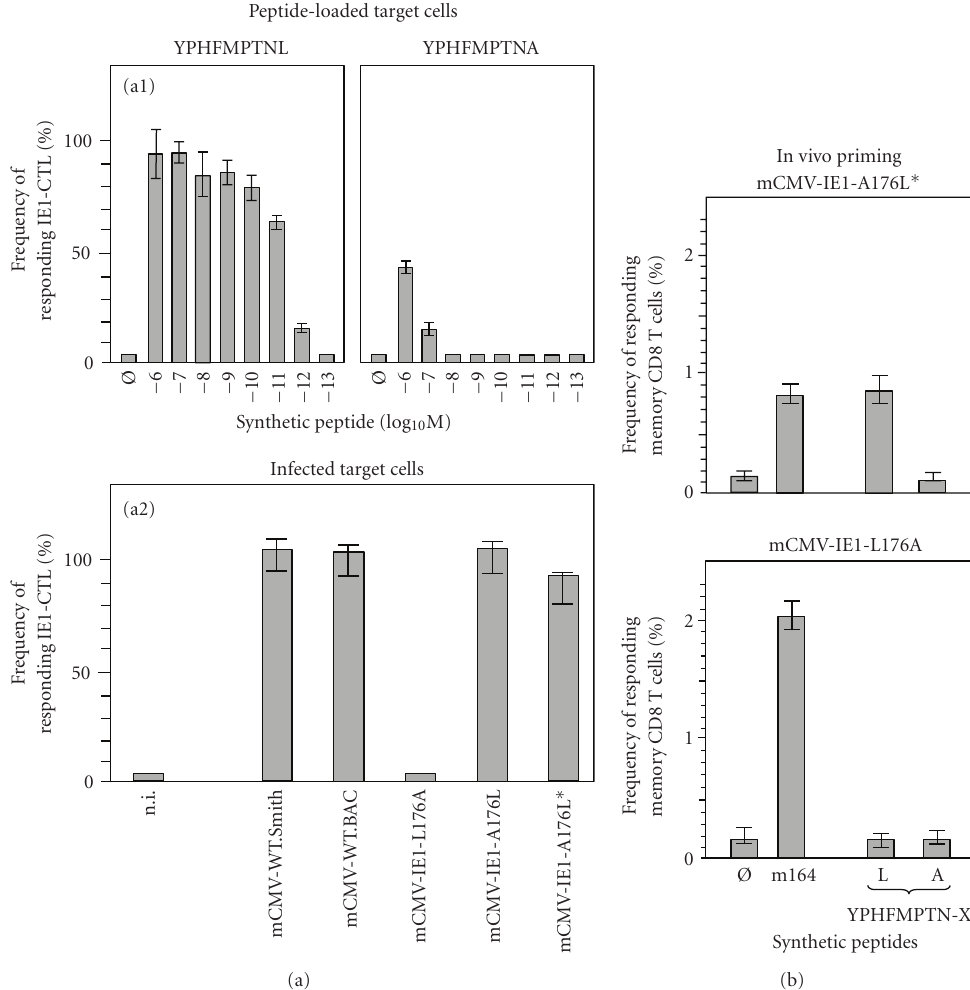
Figure 3: Verification of the loss-of-presentation phenotype. (a1) Loss of MHC-I H-2-L d binding by replacement of the C-terminal anchor residue Leu with Ala in the IE1 peptide. The response of a polyclonal IE1-specific CTLL, representing a broad TCR a ffi nity repertoire, was measured in an IFN- γ -based ELISpot assay performed with L d -expressing stimulator cells loaded exogenously with the indicated synthetic peptides at graded molar concentrations. Recognition of pMHC complexes by CTL serves as an indirect measure for pMHC formation by peptide binding to the presenting MHC-I molecule ∅ , no peptide added. Note that presented IE1-Ala analog is recognized only by high-avidity CTL after high-dose peptide loading. (a2) Loss of endogenous peptide presentation by the mutation L176A. The response of an IE1-CTLL (see above) was measured with L d -expressing stimulator cells that were infected with the indicated WT, mutant, or revertant viruses (see also Table 1). n.i., not infected as a negative control. Note the selective lack of recognition of stimulator cells infected with mutant virus mCMV-IE1-L176A. (b) Loss of in vivo immunogenicity by the mutation L176A. BALB/c (H-2 d haplotype) mice were infected with “wobble” revertant virus or with mutant virus (see Figure 2), and ex vivo isolated memory CD8 T cells were used as e ff ector cells in an IFN- γ -based ELISpot assay performed with L d -expressing stimulator cells that were loaded exogenously with saturating doses of the indicated synthetic peptides ∅ , no peptide added. Note the selective loss of IE1-specific CD8 T-cell priming after infection with mutant virus mCMV- IE1-L176A. See Simon et al. [8] for further explanation and experimental details. Reproduced in modified arrangement from reference [8] with permission by the Journal of Virology (American Society for